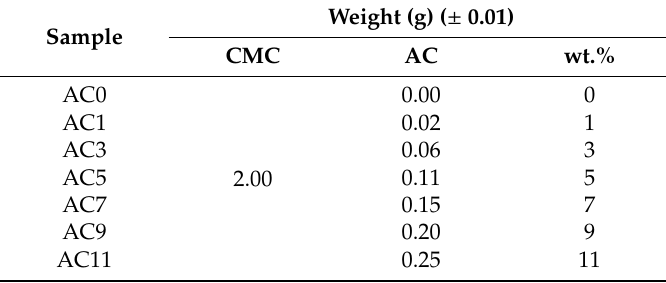
Table 1. The carboxymethyl cellulose-ammonium carbonate (CMC-AC) electrolyte